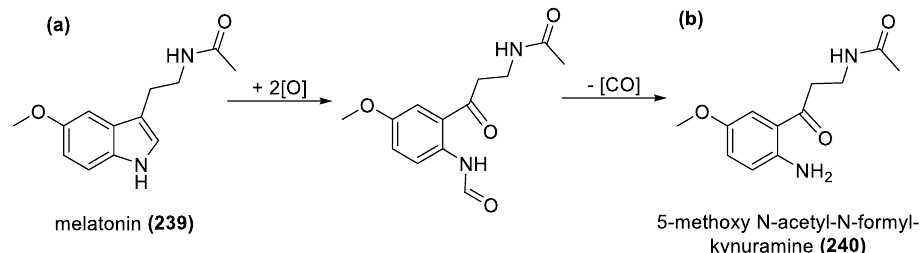
Figure 16. Melatonin ( a ) and its reaction to form 5-methoxy N-acetyl-N-formylkynuramine ( b ). Pyrroles